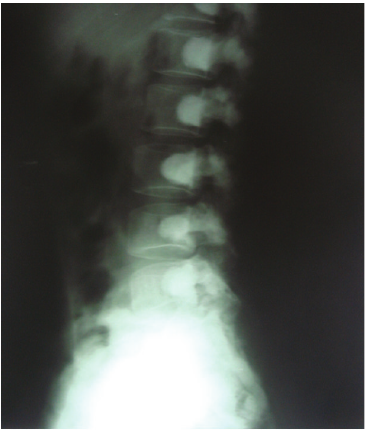
Figure 5: Anteroposterior view of the cervical vertebra showing increased radiodensity in all the cervical vertebrae.